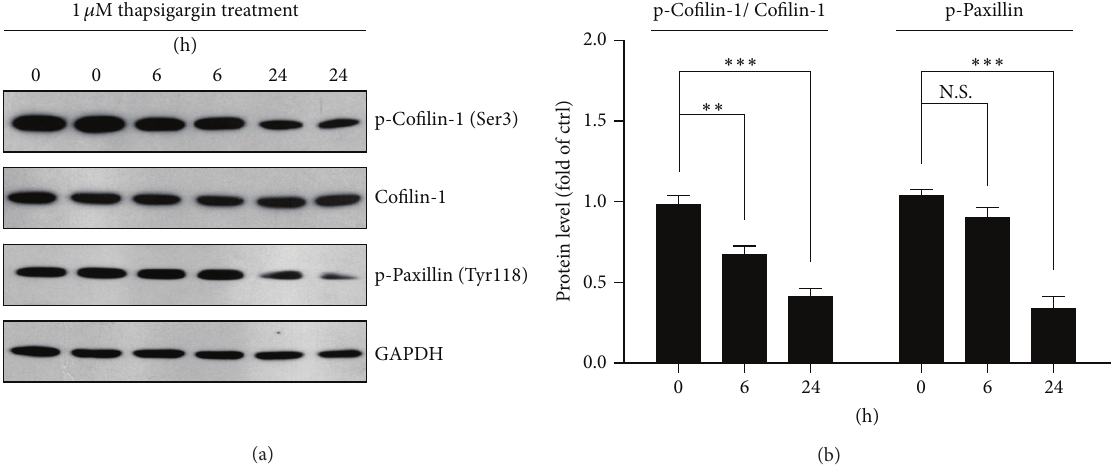
Figure 3: Thapsigargin disrupts actin cytoskeletal proteins in A549 cells. The reductions of protein levels of p-Cofilin-1 (Ser3) and p-Paxillin (Tyr118) by thapsigargin treatment (1 𝜇 M for 6 and 24 h) in A549 cells were shown by Western blots (a) and histograms (b). Notes showed that the protein level of total Cofilin-1 is not affected by thapsigargin treatment. Results are averages of four independent experiments. Data represent mean ± SEM. ∗∗ 𝑃 < 0.01 , ∗∗∗ 𝑃 < 0.001 , N.S, and no statistical